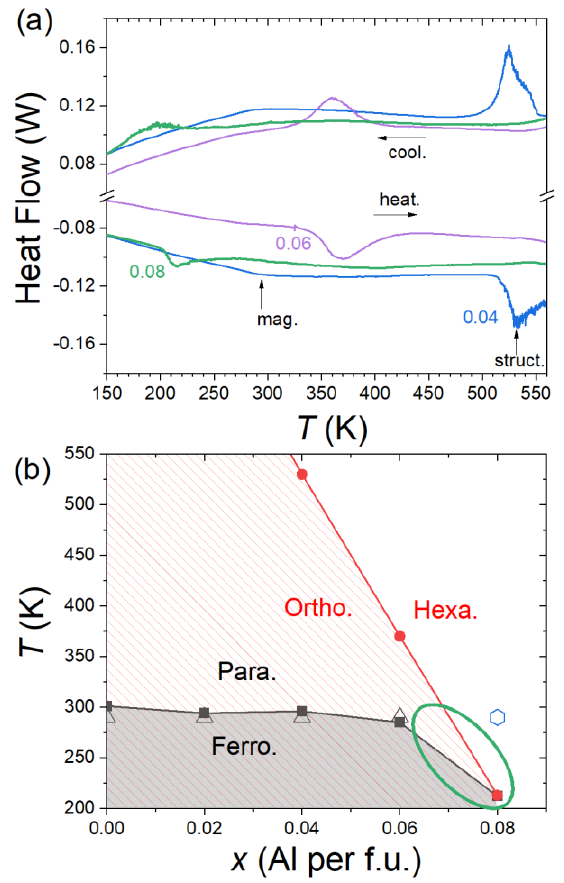
Figure 3. ( a ) DSC measurements of MnFe 0.6 Ni 0.4 Si 1- x Al x compounds carried out at 10 K min −1 upon heating (lower set of curves) and cooling (upper set of curves). The arrows illustrate the location of the magnetic (mag.) and structural (struct.) transitions for x = 0.04; ( b ) structural and magnetic phase diagram displaying the Curie temperatures determined from M ( T ) measurements at low magnetic fields (filled squares), the structural ortho. – hexa. transition (filled circles) determined from DSC measurements and the main structure type at room temperature established by XRD (open triangles for TiNiSi type, open hexagon for Ni 2 In type). The circle highlights the range where a magneto-structural coupling is expected.